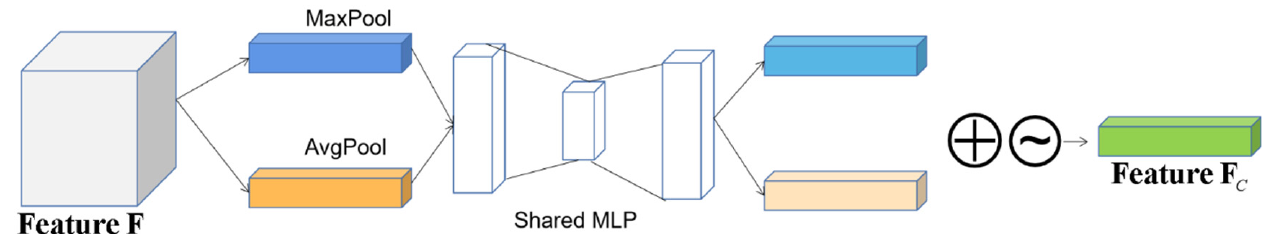
Figure 4. Channel attention module. Figure 5 depicts the structure of the SA module. Not all regions in the image contribute equally to the task. Only the regions related to the task need to be concerned. The SA model aims to find the most important part of the network for processing. F C (cid:48) is the input of SA, F C (cid:48) also goes through the maximum pooling layer and the average pooling layer, and their outputs are concatenated on the channel dimension. Then, a convolution layer and a sigmoid function are connected to obtain feature F S